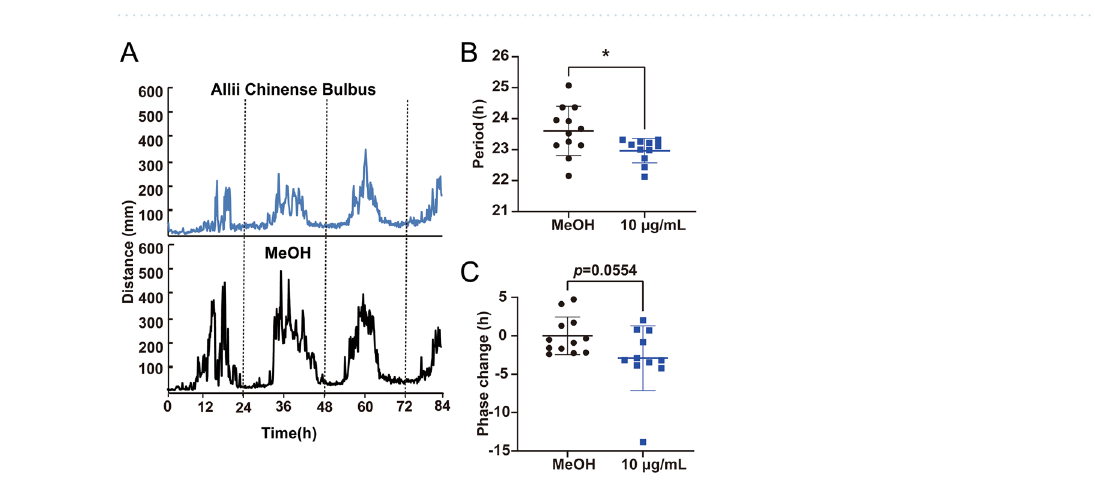
Figure 3. Effect of three crude drug extracts on Rat-1 fibroblasts expressing Per2-luc and lung explants from Per2::Luciferase knockin mice. ( A ) Luminescent traces (left) and dose-dependent effects on the circadian period (middle) and phase (right) in Rat-1 cells. Values are averages of three replicates ± SD and were analyzed using one-way ANOVA, followed by Dunnett’s multiple comparisons test (* p < 0.05, ** p < 0.01, *** p < 0.001, **** p < 0.0001). ( B ) Effects of the extracts of Artemisiae Capillaris Flos (top), Perillae Herba (middle), and Allii Chinense Bulbus (bottom) on lung explants of Per2::Luciferase knockin mice. Luminescent traces (left) and effects on period (middle) and phase (right). Values are averages of three replicates ± SD and were analyzed using Student’s t-test. (* p < 0.05).